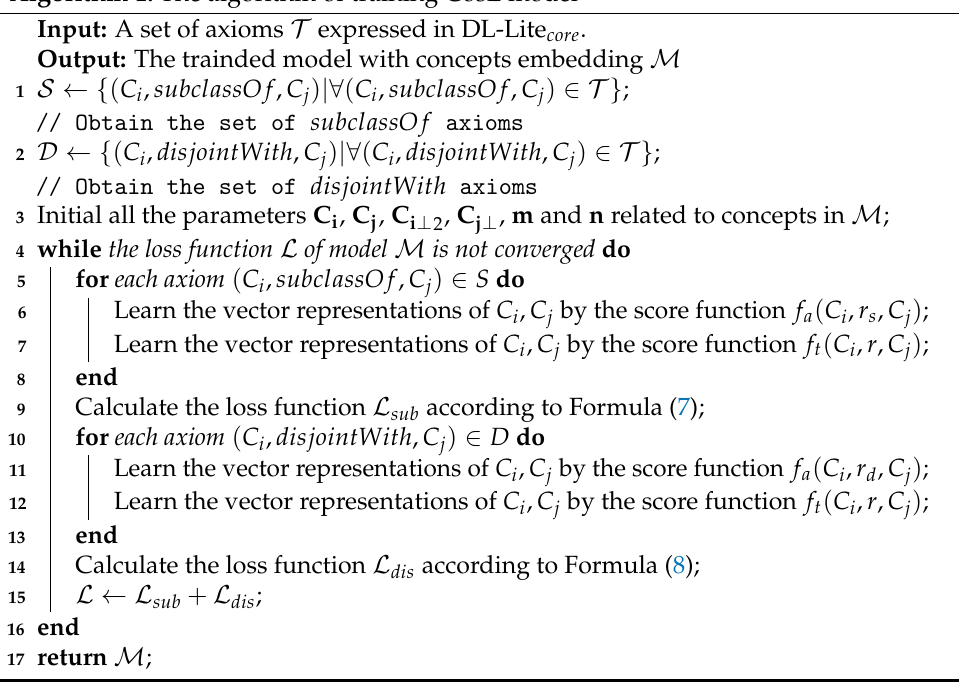
Algorithm 1: The algorithm of training CosE